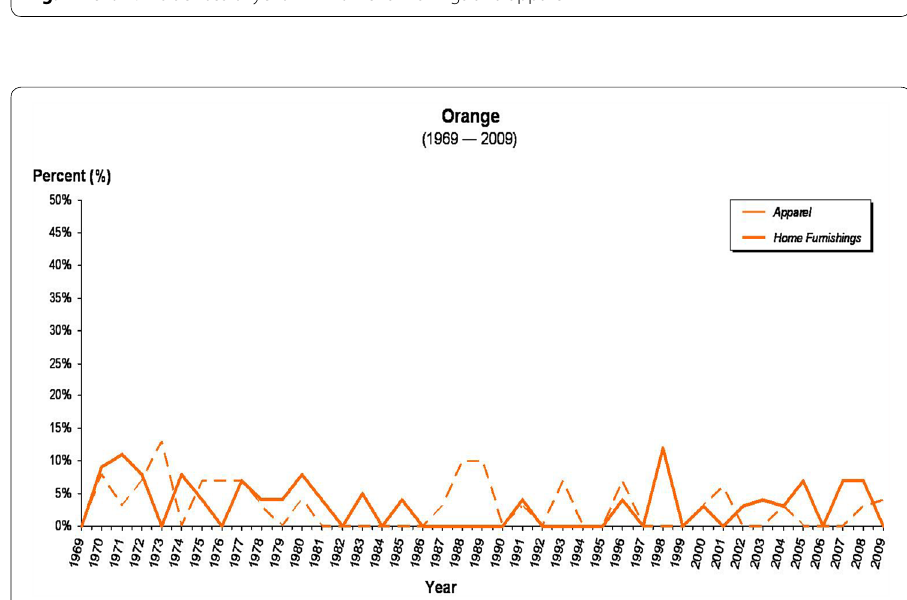
Fig. 2 Orange: incidences of orange in home furnishings and